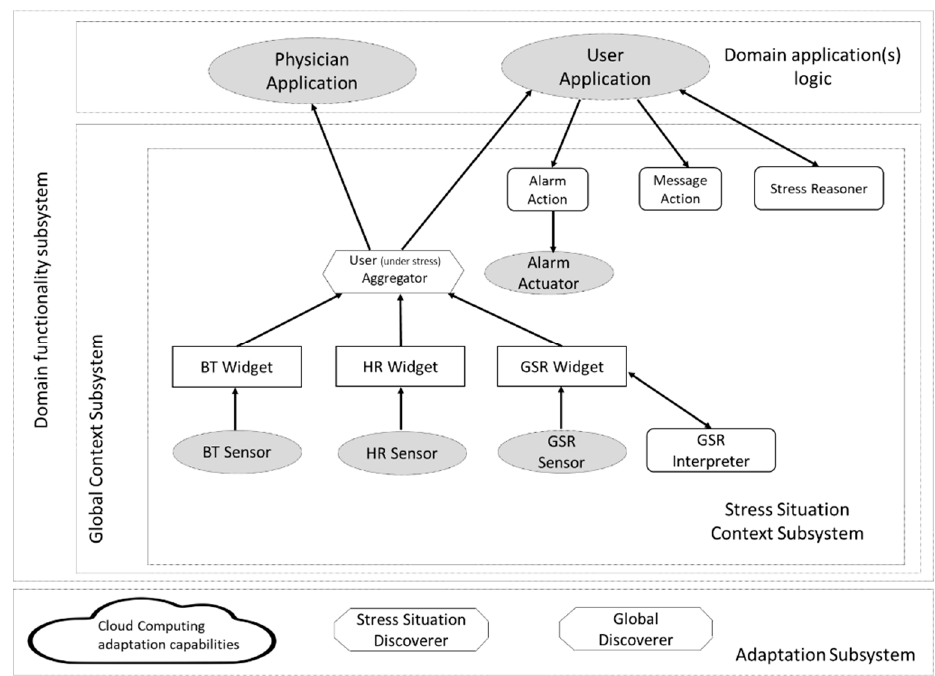
Figure 2. Stress situation context subsystem (adapted from [18]) of the global context subsystem as part of the redefined application layer by the proposed framework. BT: Body Temperature; HR: Heart Rate; GSR: Galvanic Skin